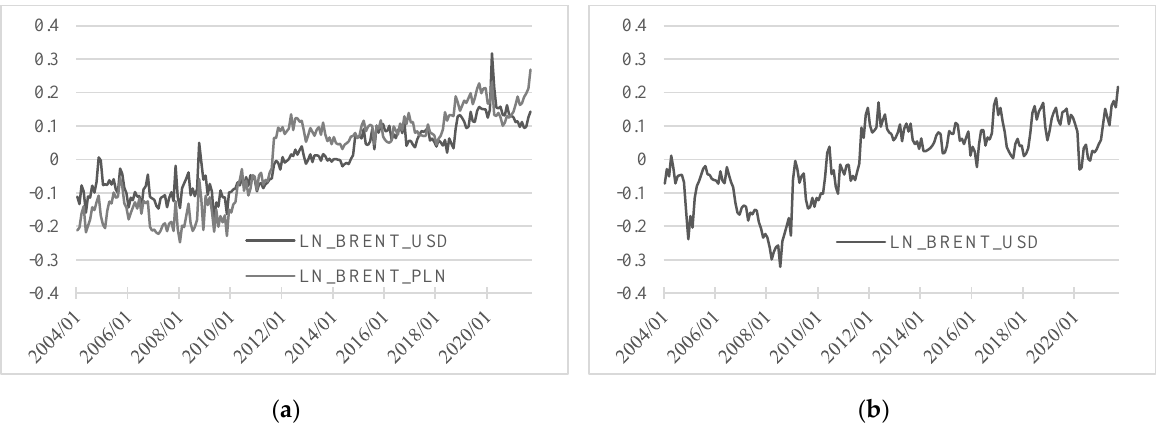
Figure 3. Residuals from cointegrating models: ( a ) LN_ON (Orlen); ( b ) LN_BRENT_PLN.